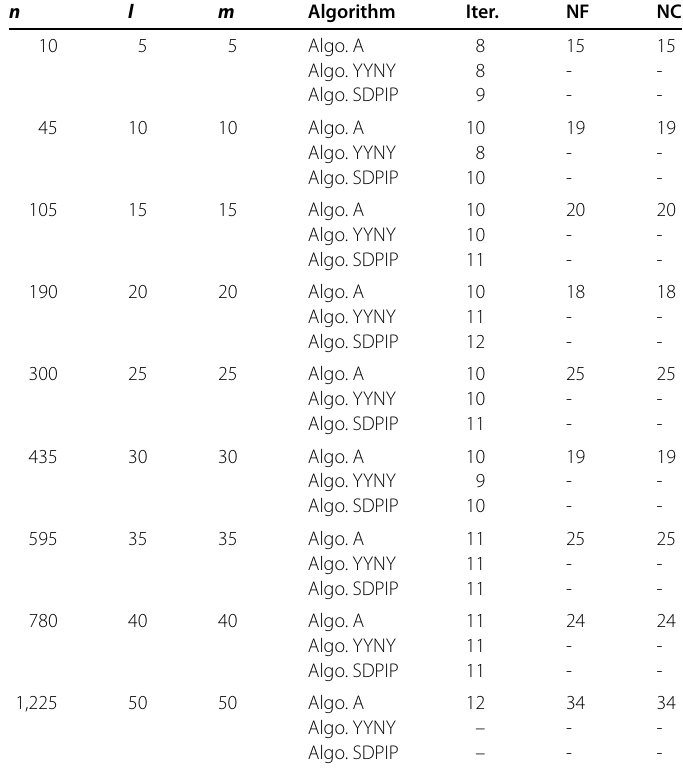
Table 2 The numerical results for NCM